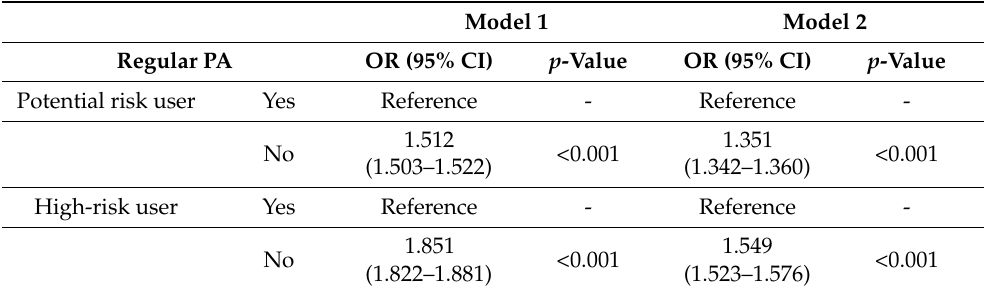
Table 6. Logistic regression analysis on level of smartphone addiction based on regular